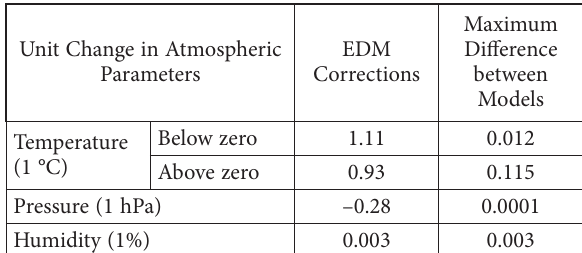
Table 3. EDM corrections by unit change in atmospheric parameters plus maximum difference between correction models (ppm) Unit Change in Atmospheric EDM Parameters